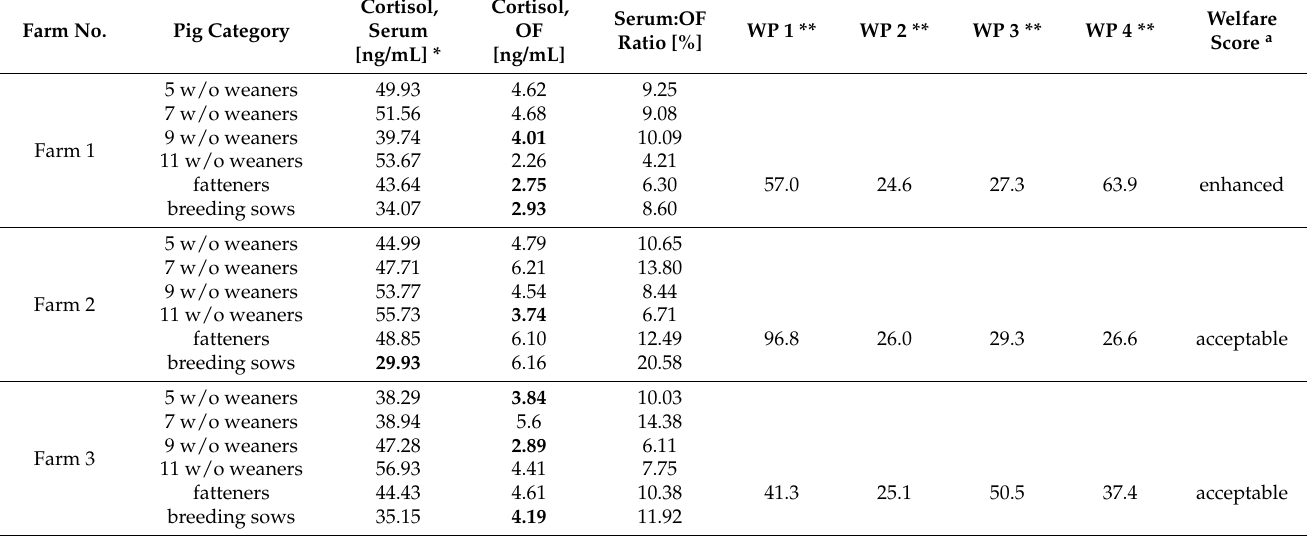
Table 2. Cortisol levels in sera and OF, and welfare scores assigned by the WQ Protocol ®